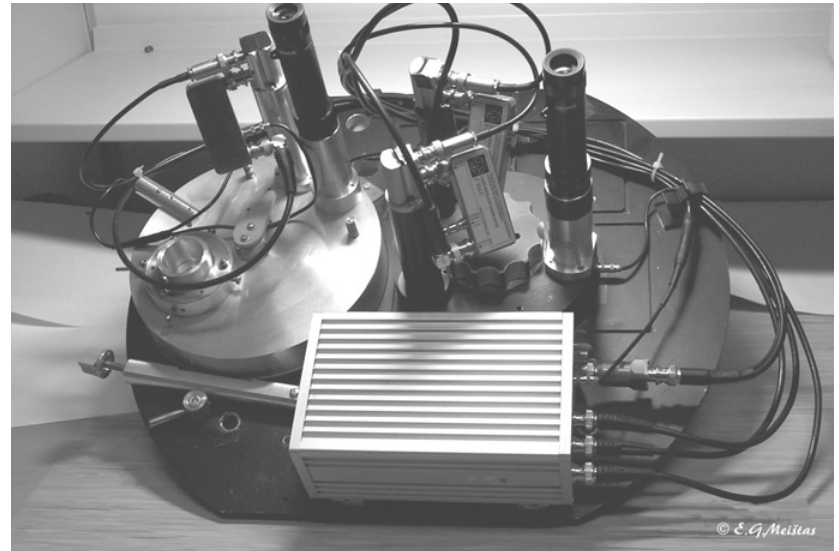
Fig. 3. The last version of the Pancake (SBIG-4 unit removed) ready to travel to sites of WET